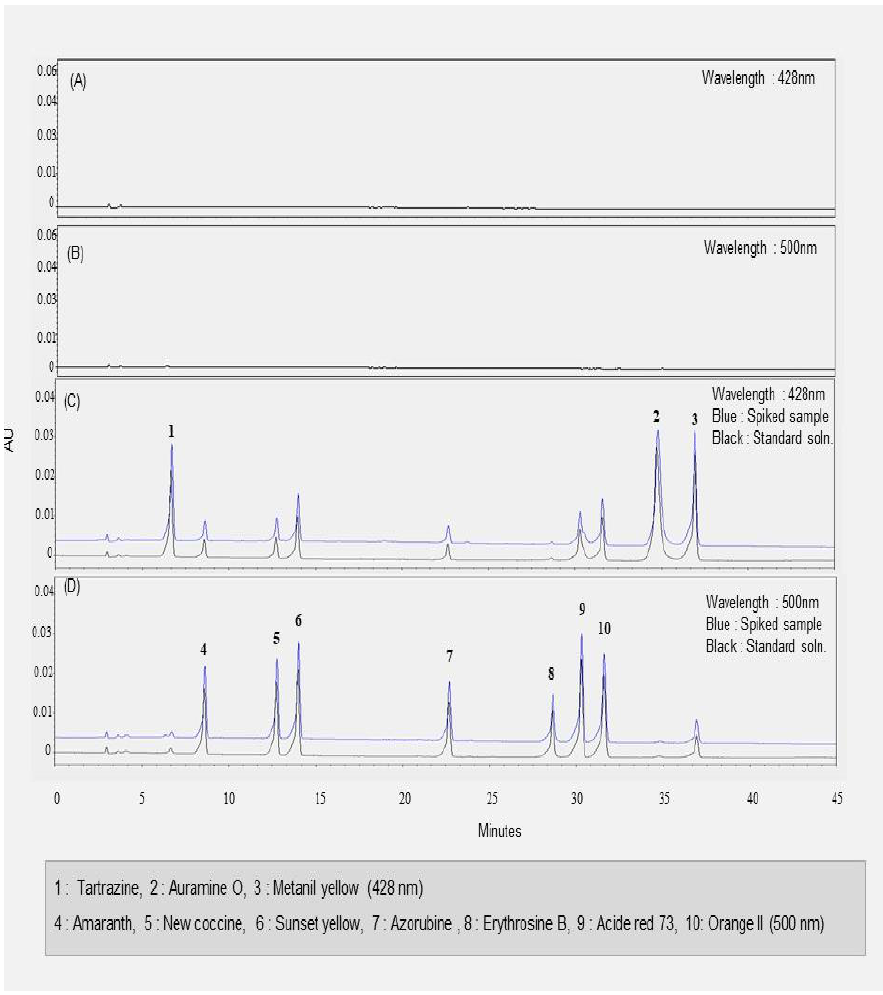
Figure 3. The HPLC chromatograms of synthetic dyes in Hawthorn fruit. ( A ) The blank sample solution at 428 nm; ( B ) the blank sample solution at 500 nm; ( C ) the mixed standard solution and spiked sample at 428 nm; ( D ) the mixed standard solution and spiked sample at 500 nm.